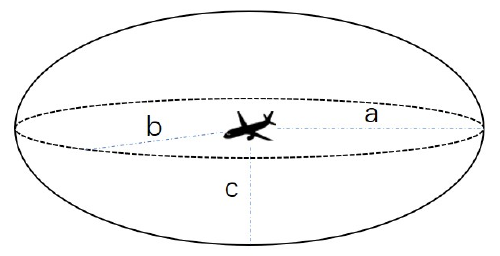
Figure 2. Aircraft flight protected area.